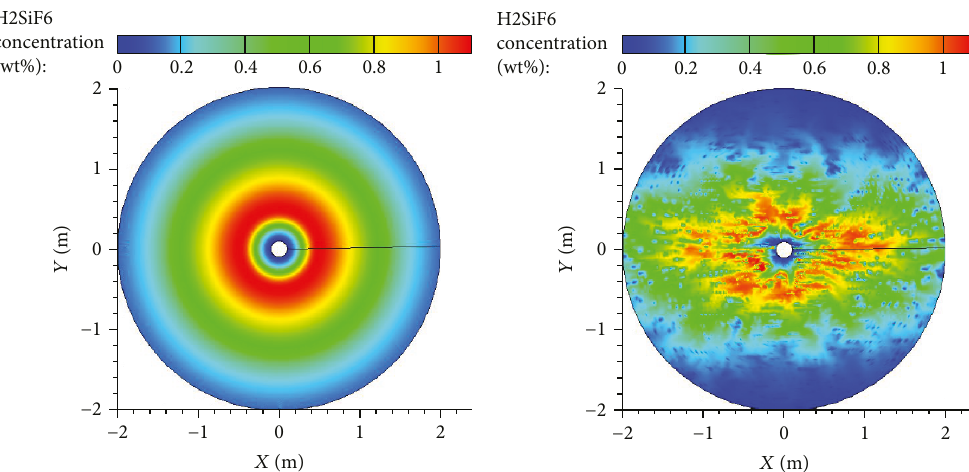
Figure 8: H SiF distribution after acidizing for homogeneous and heterogeneous initial distributions. 2 6